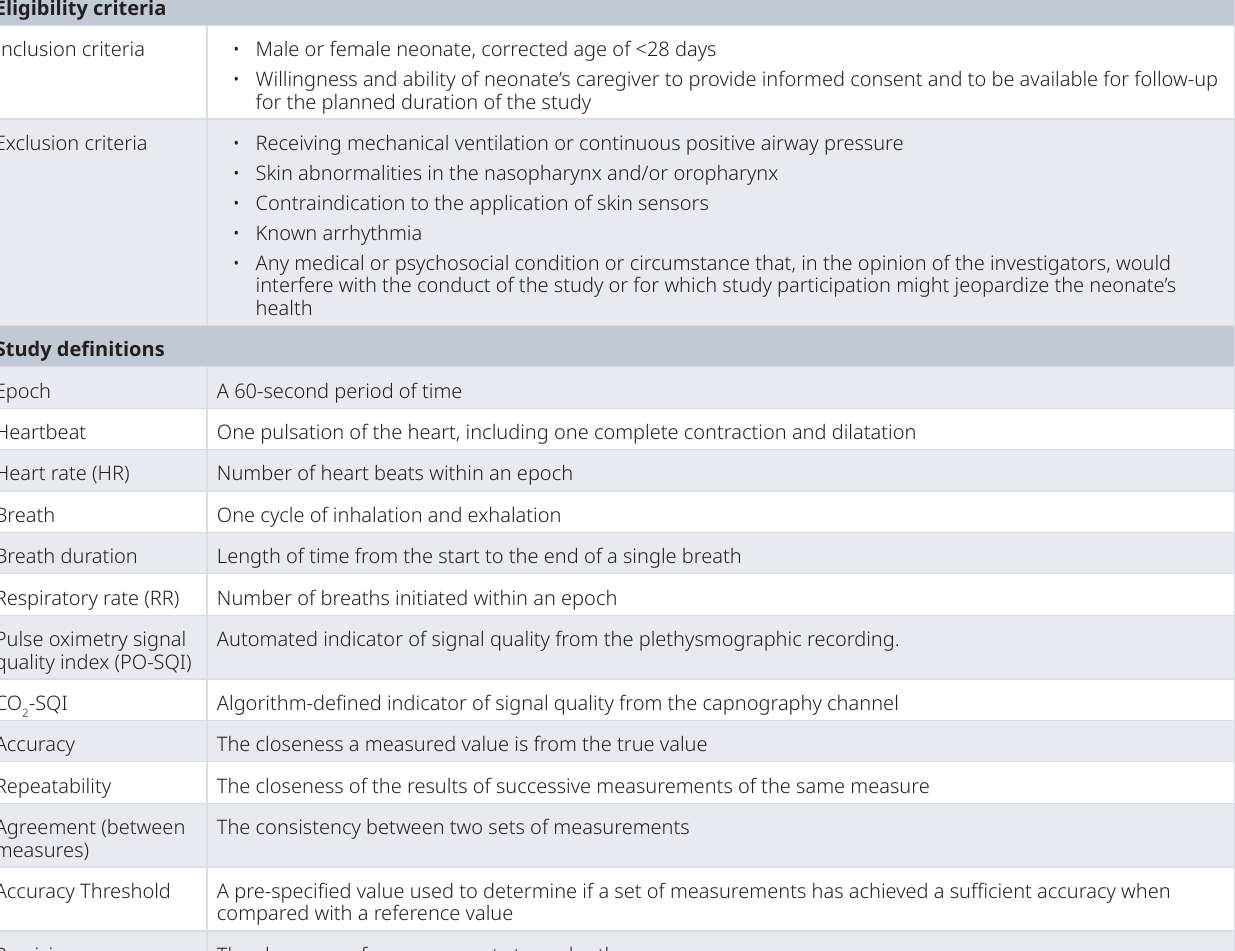
Algorithm-defined indicator of signal quality from the capnography